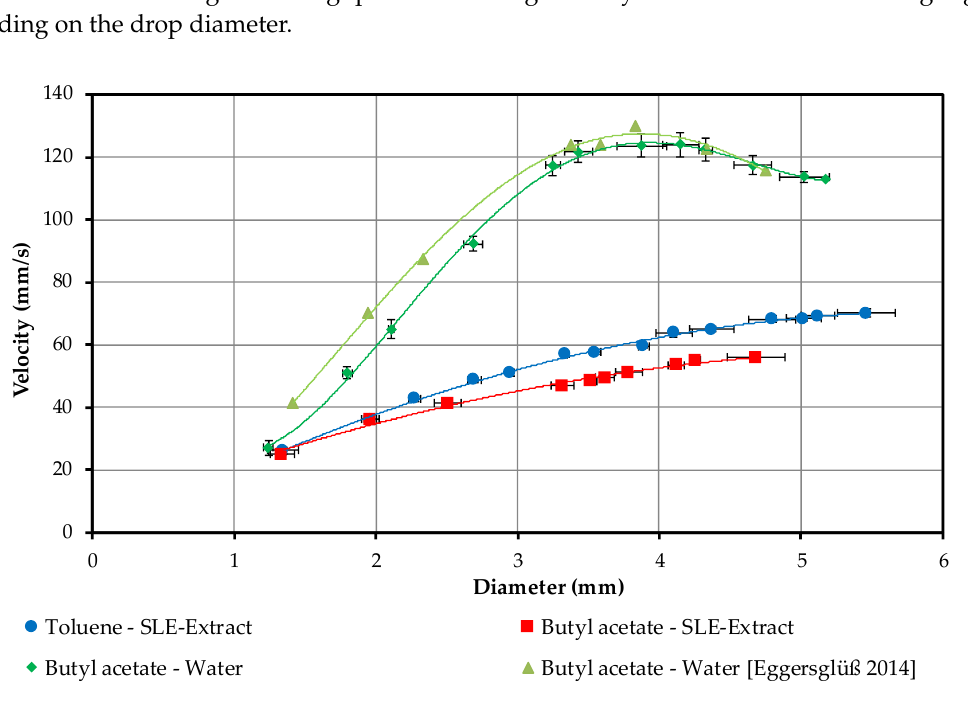
Figure 5. Droplet rise velocities of the investigated systems in relation to the droplet diameter including data from [31].